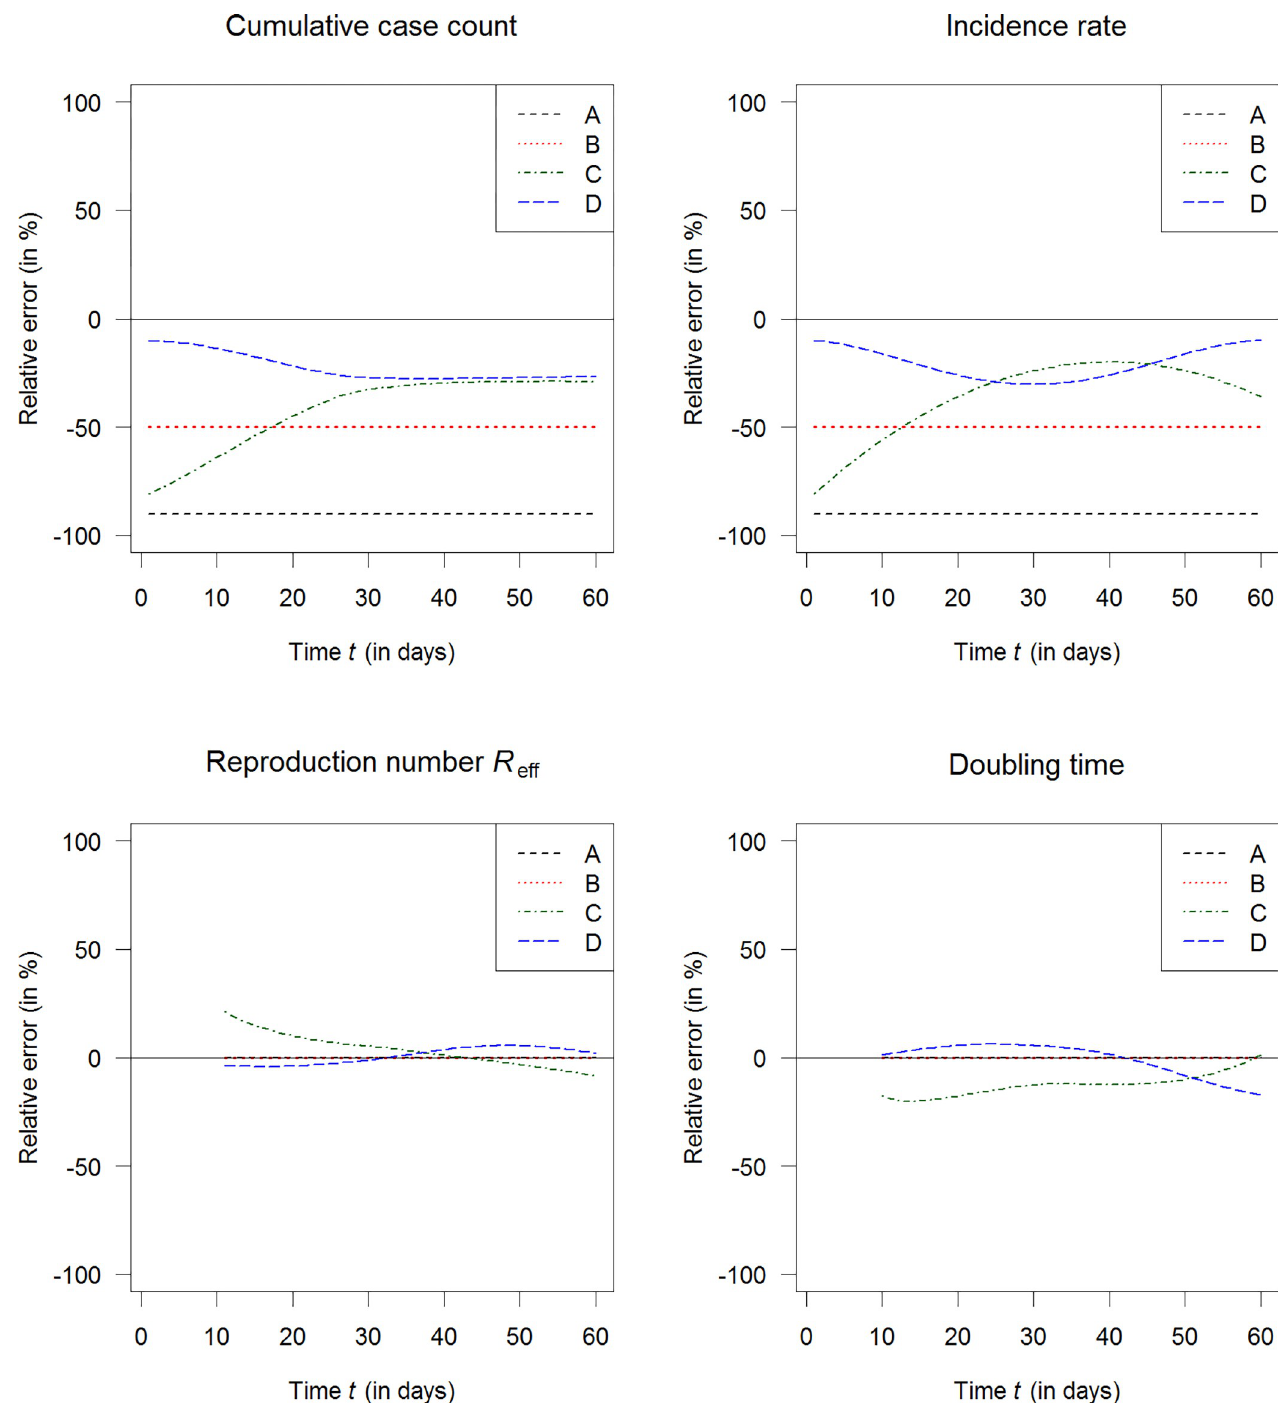
Fig 5. Biases in the simulated scenarios. Bias (relative error) of the four epidemiological measures in the four simulated scenarios A to D (indicated by the line type): Cumulative case count (top left), incidence rate (top right), effective reproduction number (bottom left) and doubling time (bottom right). A desirable zero bias is indicated by a horizontal solid line at value